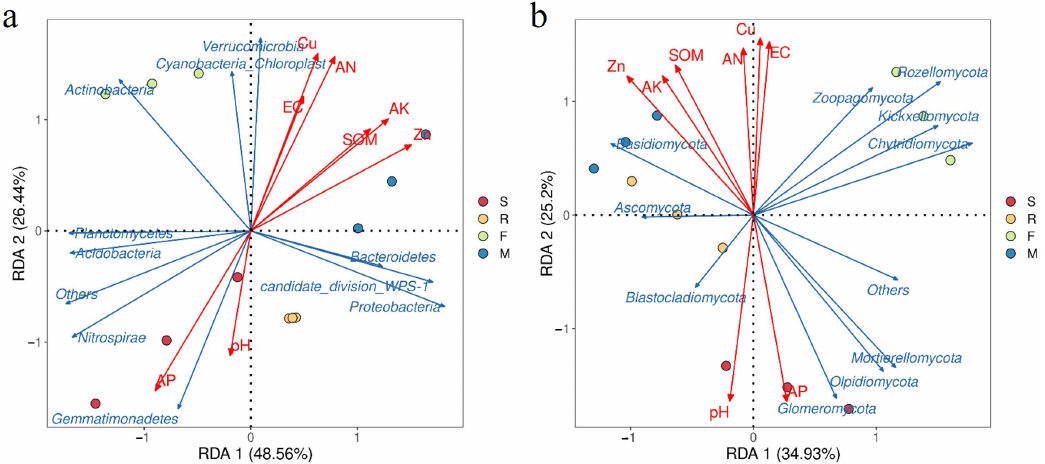
Figure 5. Redundancy analysis of the ten dominant bacterial ( a ) and fungal ( b ) phyla and soil physicochemical properties. S, R, F, and M represent the seedling stage, rapid growth stage, flowering stage, and maturity stage, respectively. SOM, soil organic matter; Cu, copper; Zn, zinc; EC, electrical conductivity; AN, available nitrogen; AP, available phosphorus; AK, available